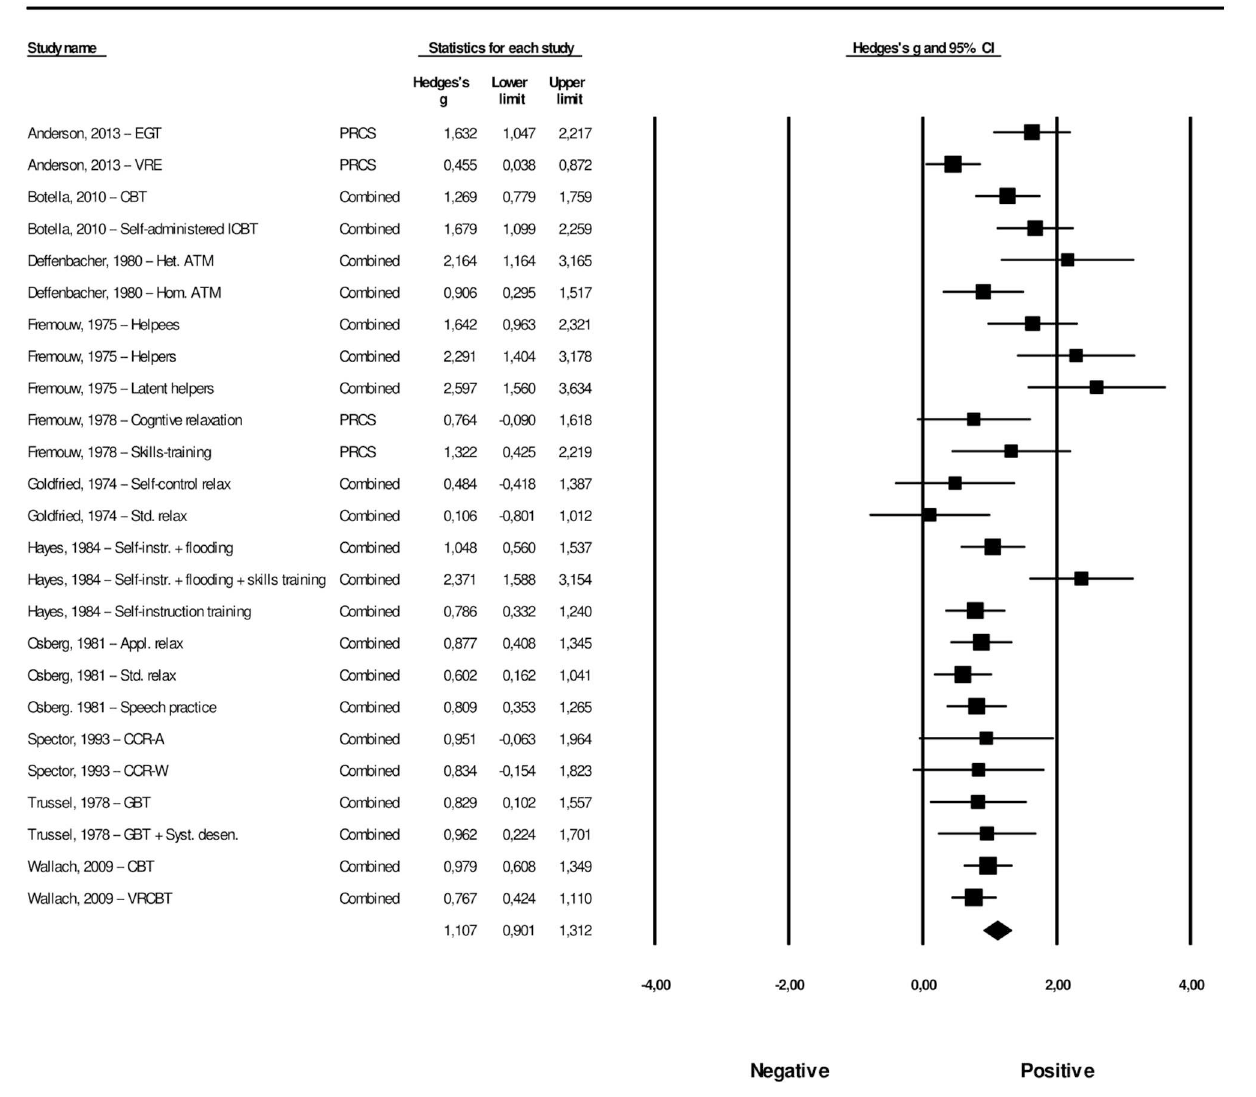
FIGURE 5 | A forest plot of the standardized effect sizes of psychological treatments aimed at fear of public speaking at